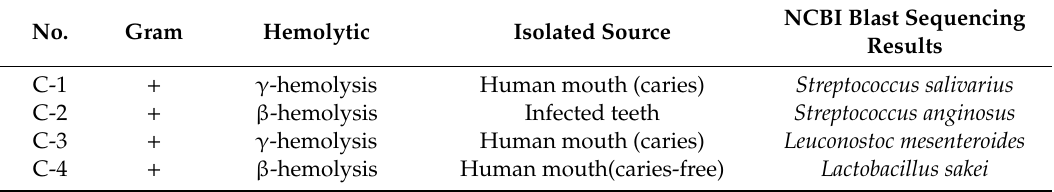
Table 1. Morphological characteristics and biotyping of the bacterial